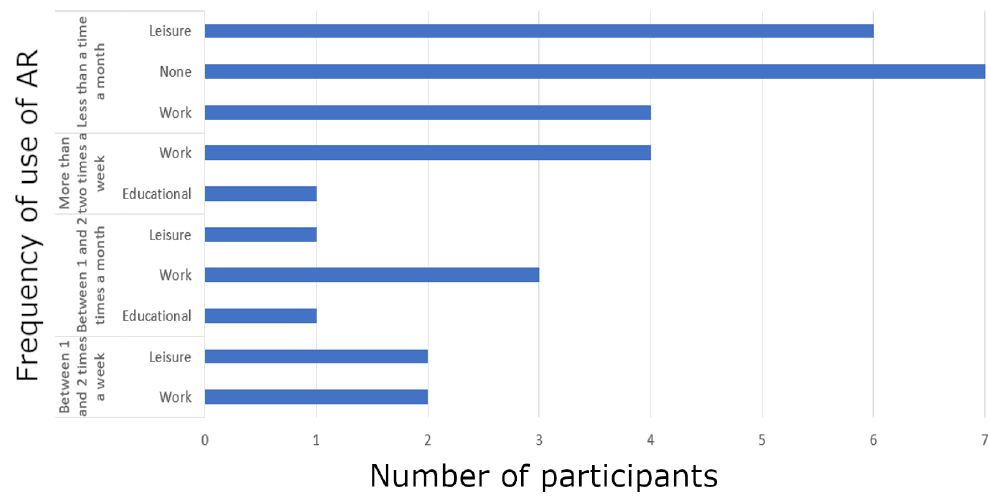
Figure 13. User experience with